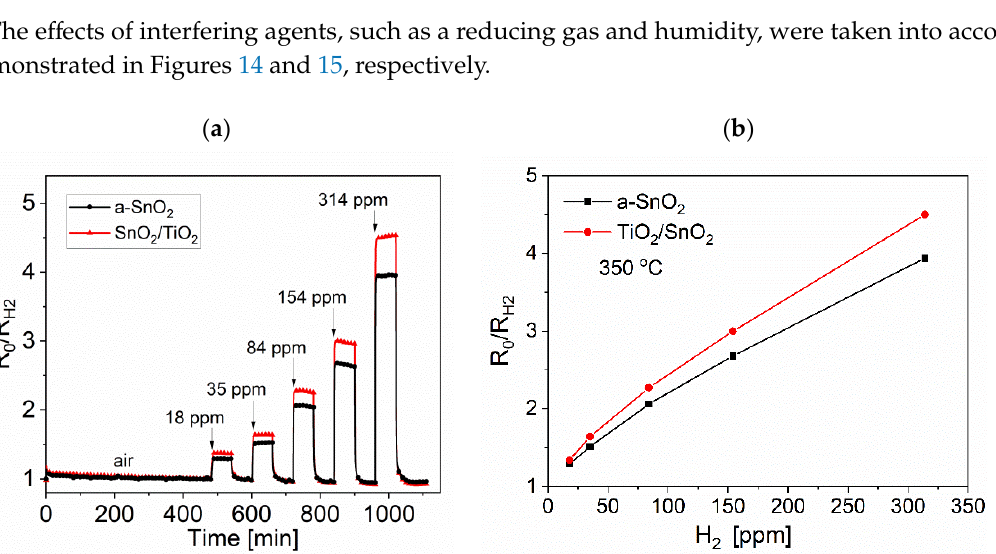
Figure 14. Responses R 0 / R H2 of a-SnO 2 and SnO 2 / TiO 2 thin films to step changes in H 2 measured according to scenario CT: ( a ) dynamic characteristics at 350 ◦ C and ( b ) response as a function of H 2 concentration at 350 ° C.